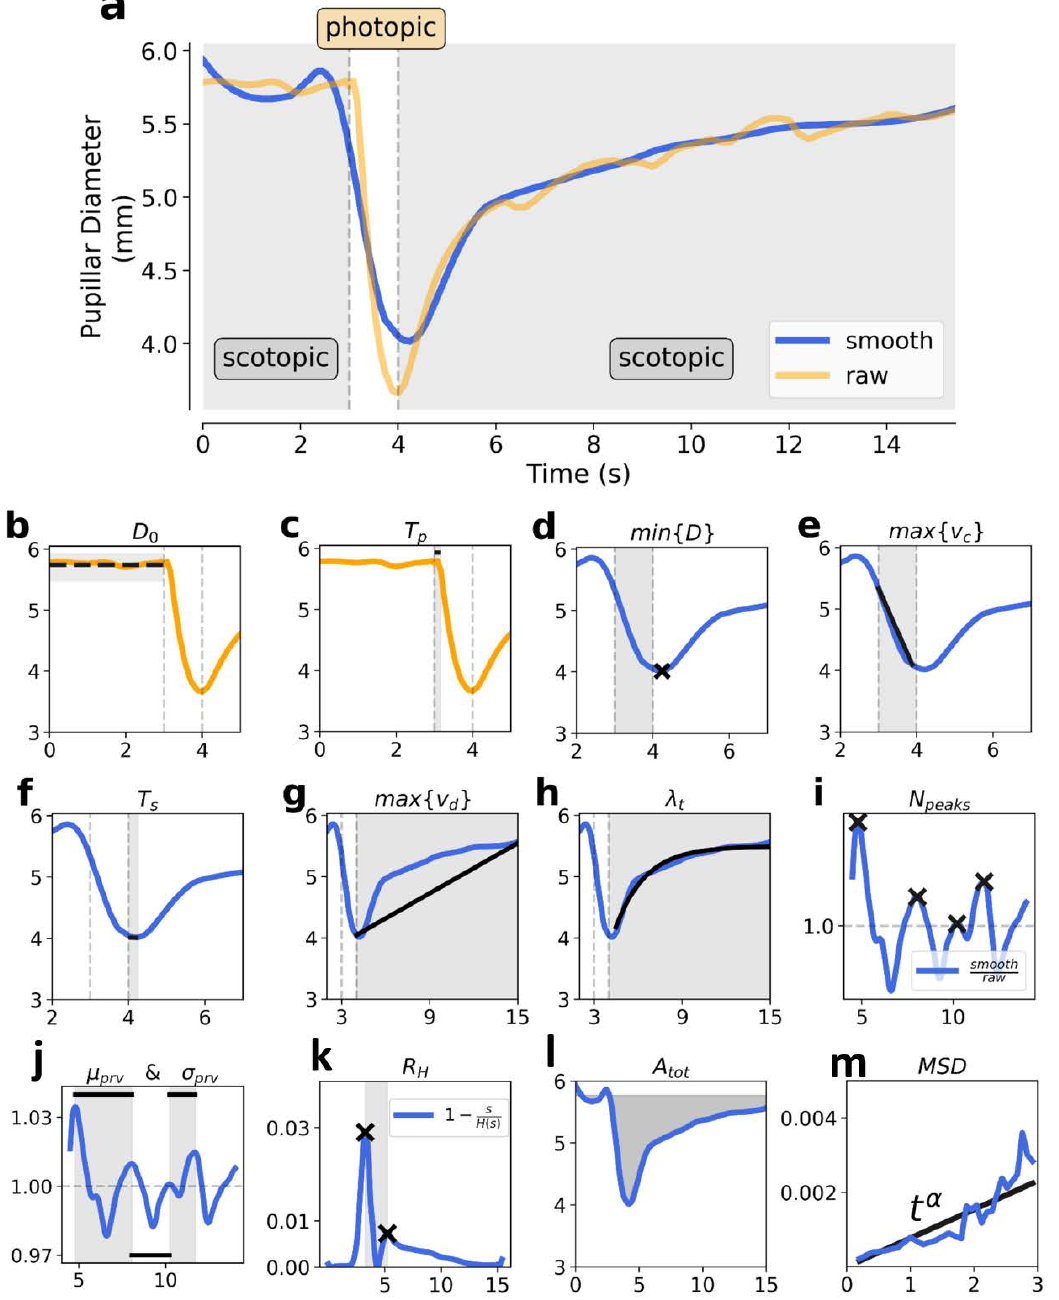
Figure 1. ( a ) Representation of the PLR signal acquired and analyzed in this work, with the highlight of the scotopic and photopic regions. In orange, we show the raw signal obtained by the pupillometer, and in blue the signal obtained by the application of a smoothing algorithm. ( b – m ) PLR features extracted and analyzed in this work. In detail, each subplot refers to: the baseline of the raw